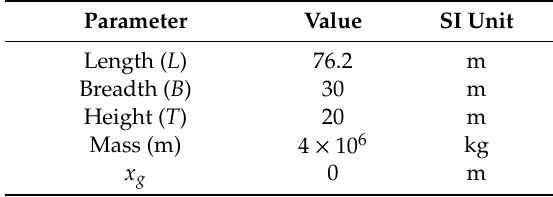
Table 2. Hydrodynamic